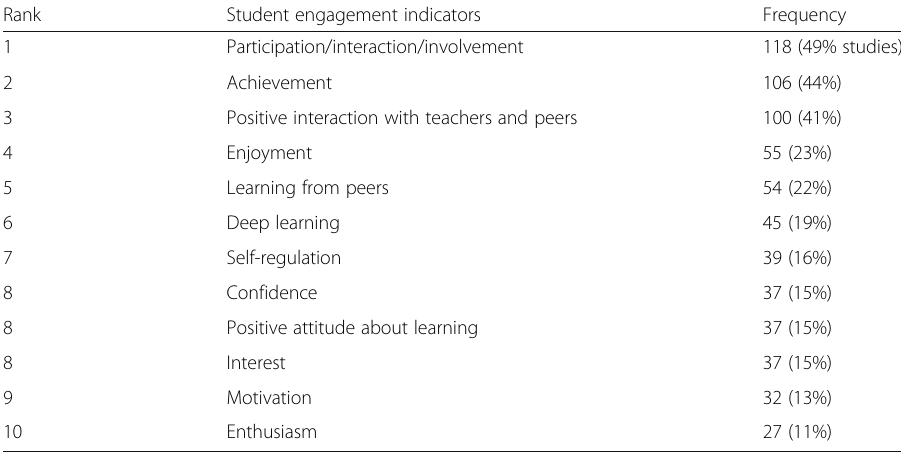
Table 2 Top ten student engagement indicators (Studies n = 243) Rank